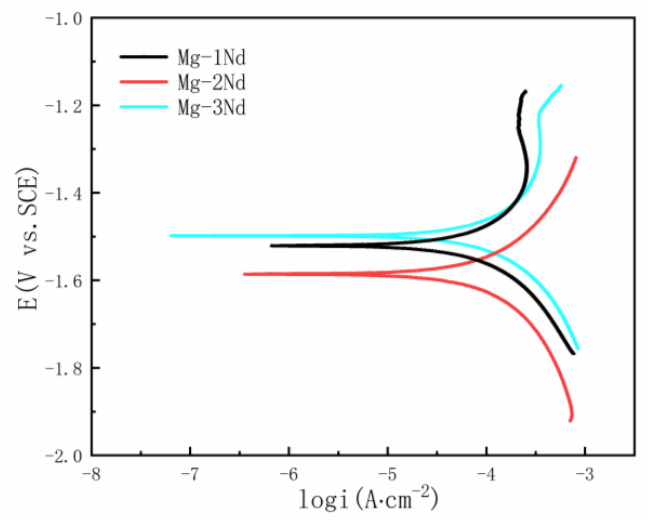
Figure 6. Potentiodynamic polarization curves of F-state Mg-Nd alloy in SRB. Table 2. Polarization curve fitting parameters for F-state Mg-Nd alloys. Alloys